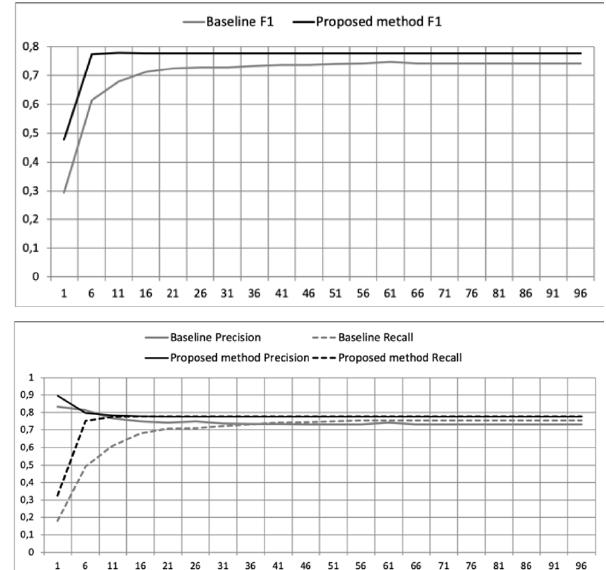
Figure 9. FilmTrust recommendation accuracy. Top chart: F1 comparative between the NCF baseline and the proposed RNCF. Chart below: Precision and Recall comparative between the NCF baseline and the proposed RNCF; x-axis: number of recommendations (N).